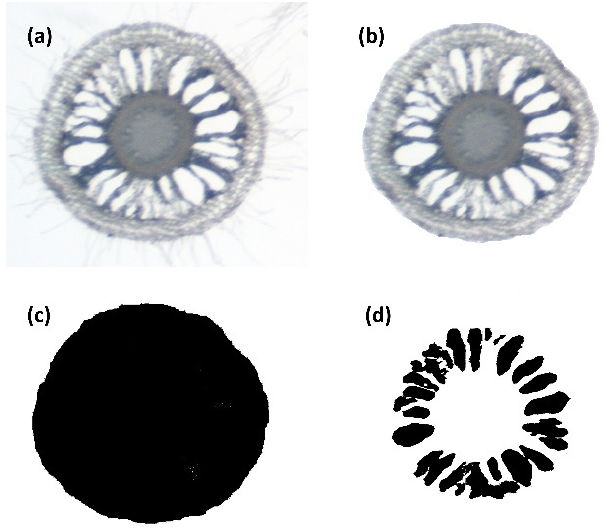
Figure 1. Representative images used ImageJ software to determine aerenchyma area. ( a ) Original digital image of root cross section, ( b ) cleaned image of root cross section after removing root hairs, ( c ) total root cross sectional area, ( d ) aerenchyma spaces. The percentage of aerenchyma was calculated by dividing the number of pixels in ( d ) by the number of pixels in ( c ).